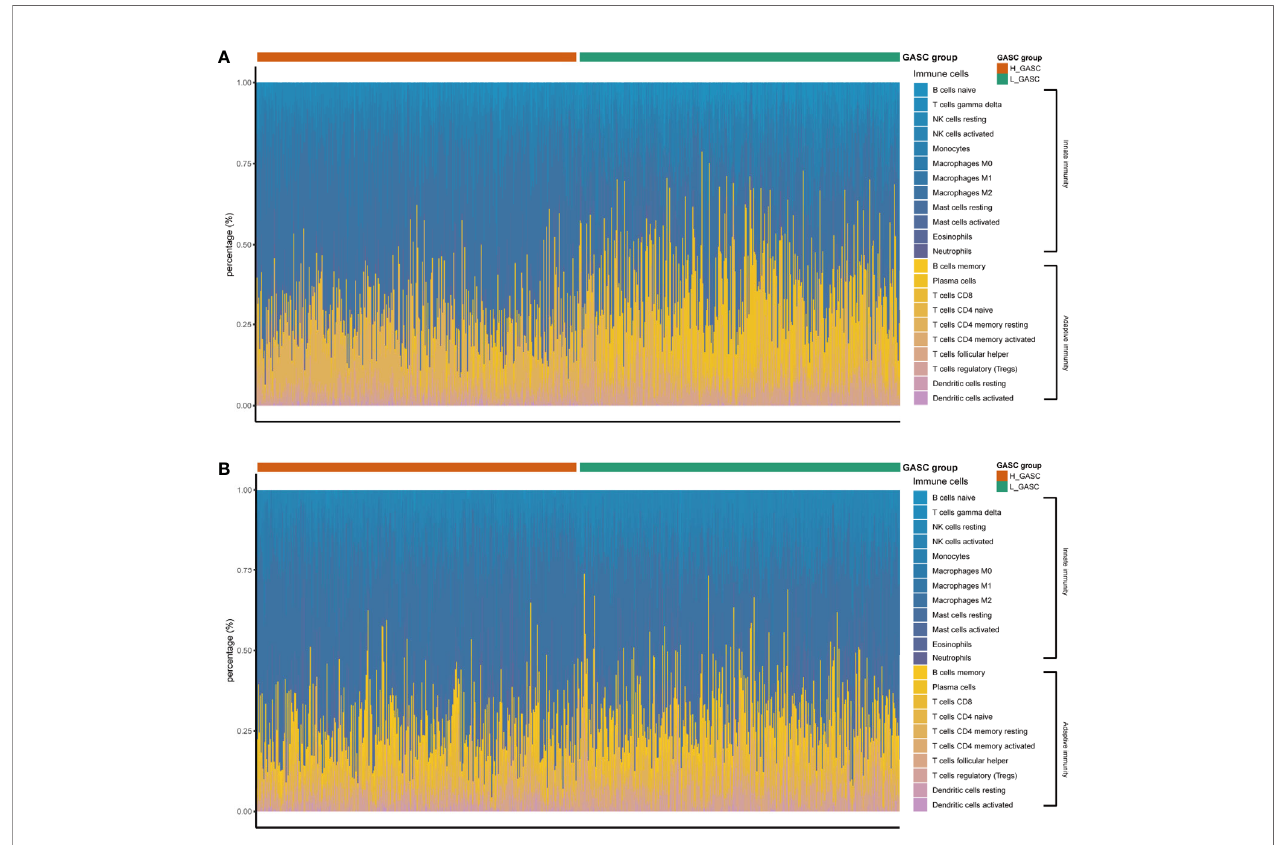
FIGURE 7 | The relative abundances of the 22 types of immune cells. (A) Results from TCAG data. (B) Results from CGGA